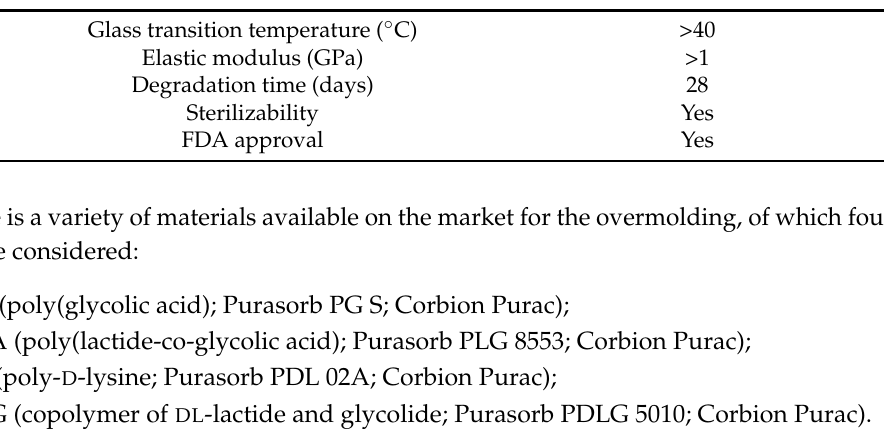
Table 1. Requirements for the biodegradable polymer [31].